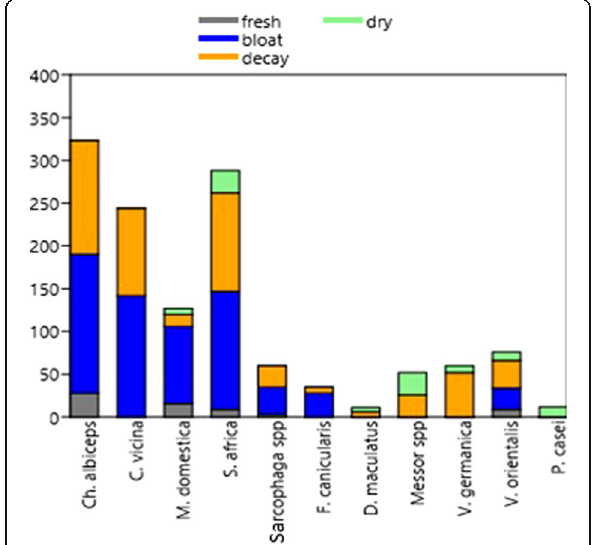
Fig. 1 Number of insect species collected in the outdoor habitat during different stages of